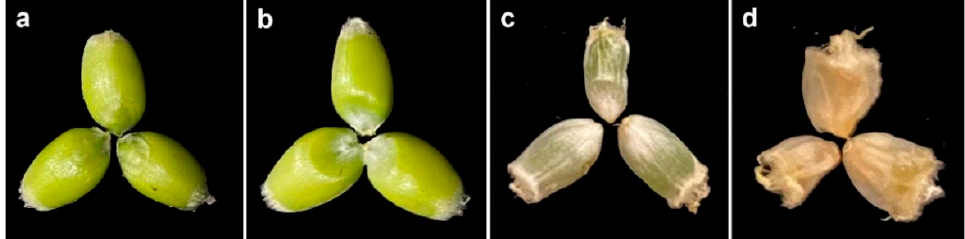
Figure 2. Wheat grain morphology of the mtl progenies. ( a ) Normal grains with embryo and endosperm; ( b ) Embryoless grains with endosperm only; ( c ) Endospermless grains, in which most ones had defective embryos and a few ones had normal embryos; ( d ) Seedcoat grains without both embryo and endosperm.